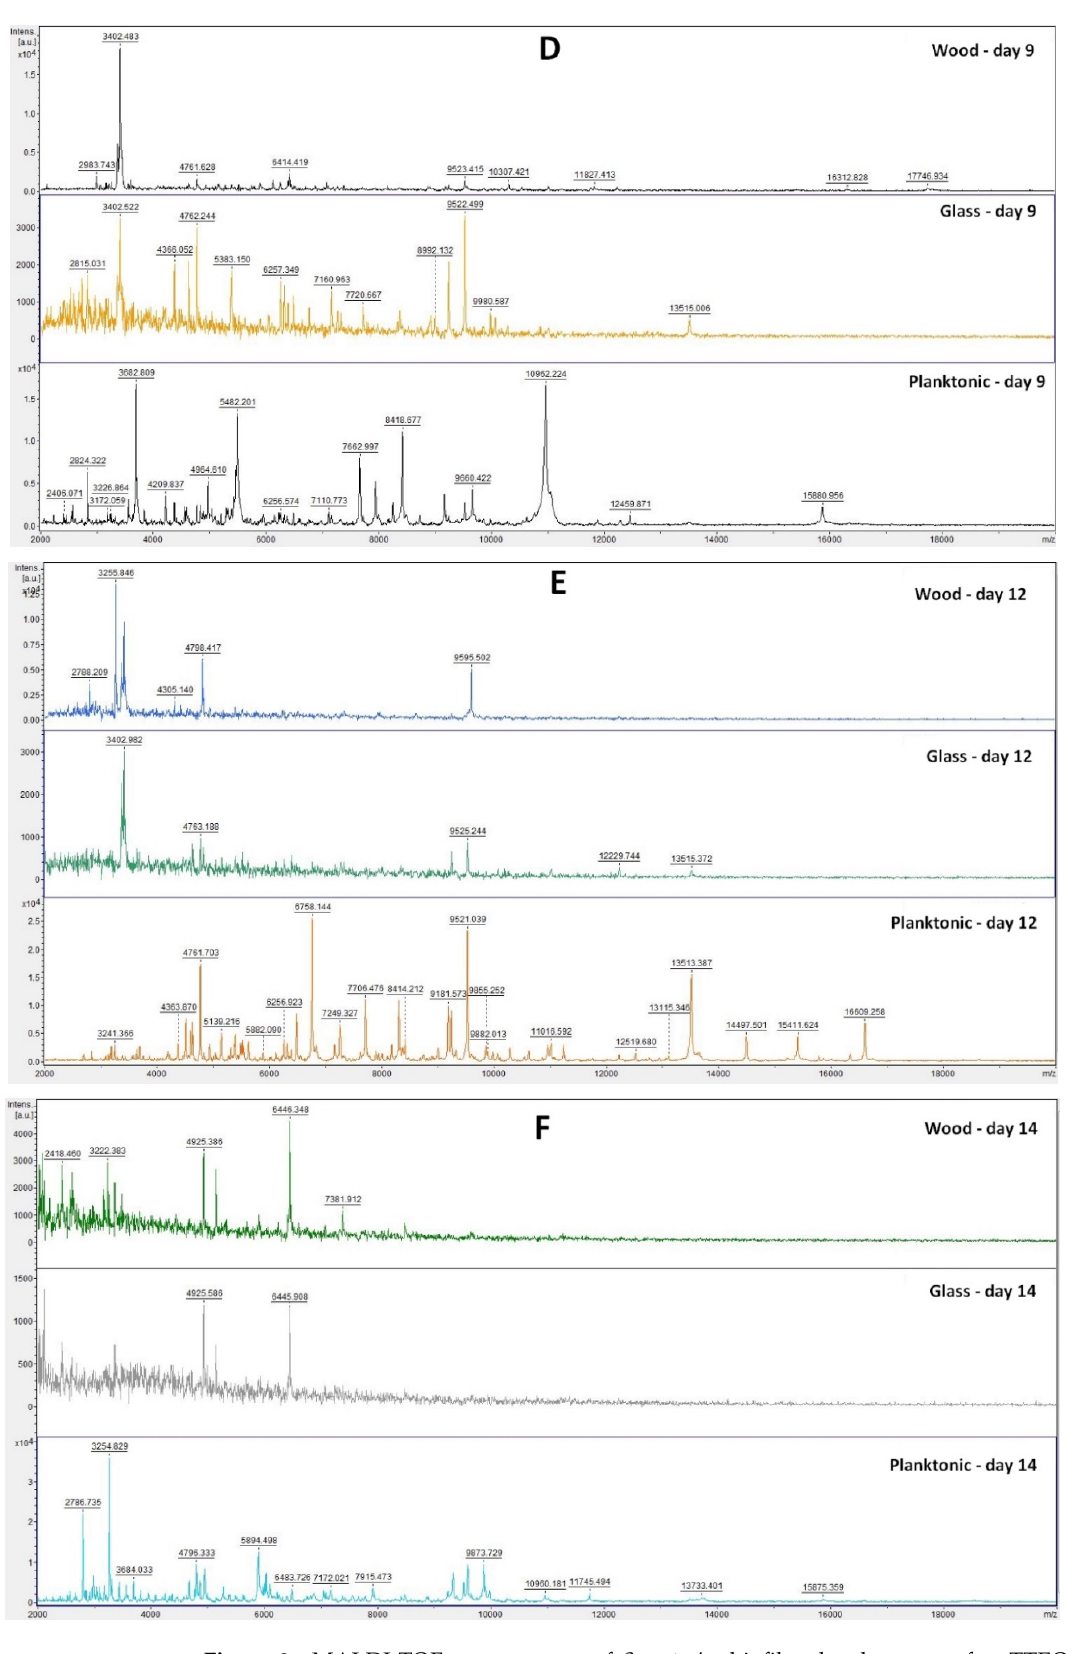
Figure 3. MALDI-TOF mass spectra of S. enterica biofilm development after TTEO exposition: ( A )